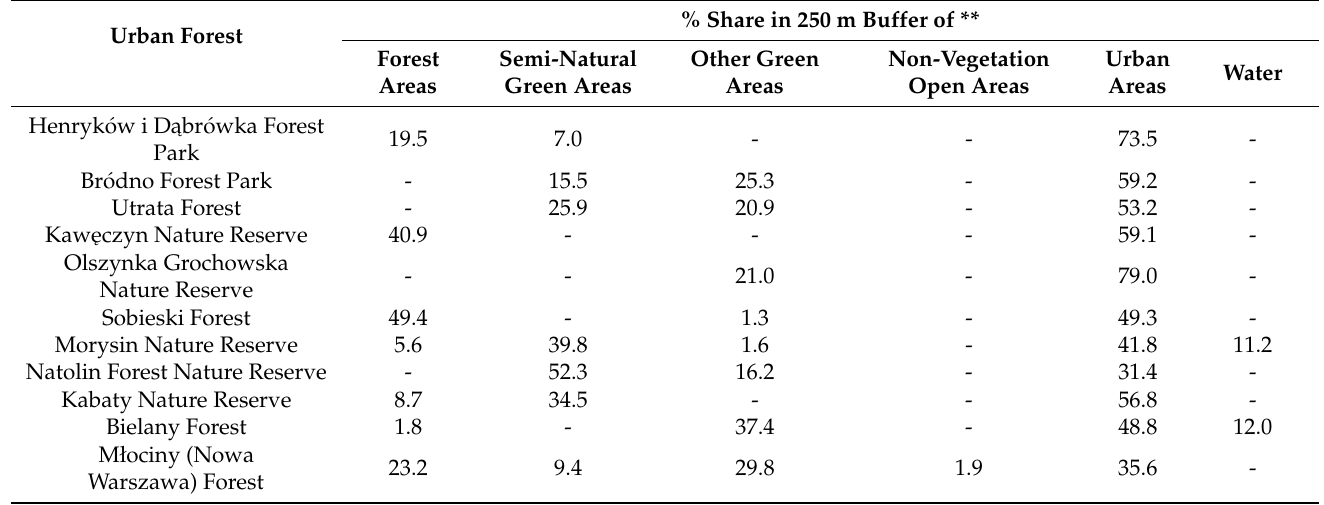
Table A3. Spatial parameters levels describing landscape connectivity for urban forests in Warsaw in the years 2019–2020. Urban Forest